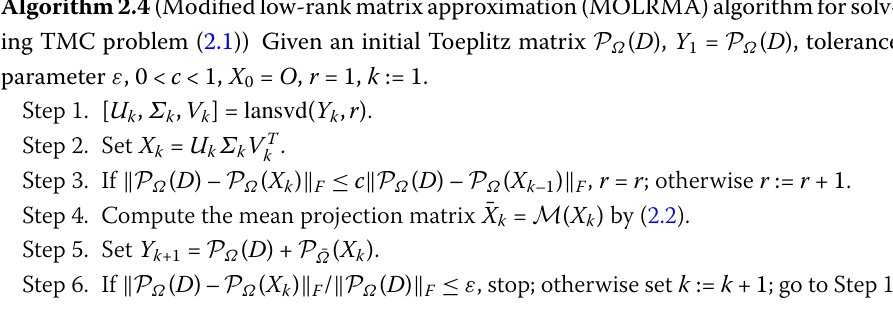
Algorithm 2.4 (Modified low-rank matrix approximation (MOLRMA) algorithm for